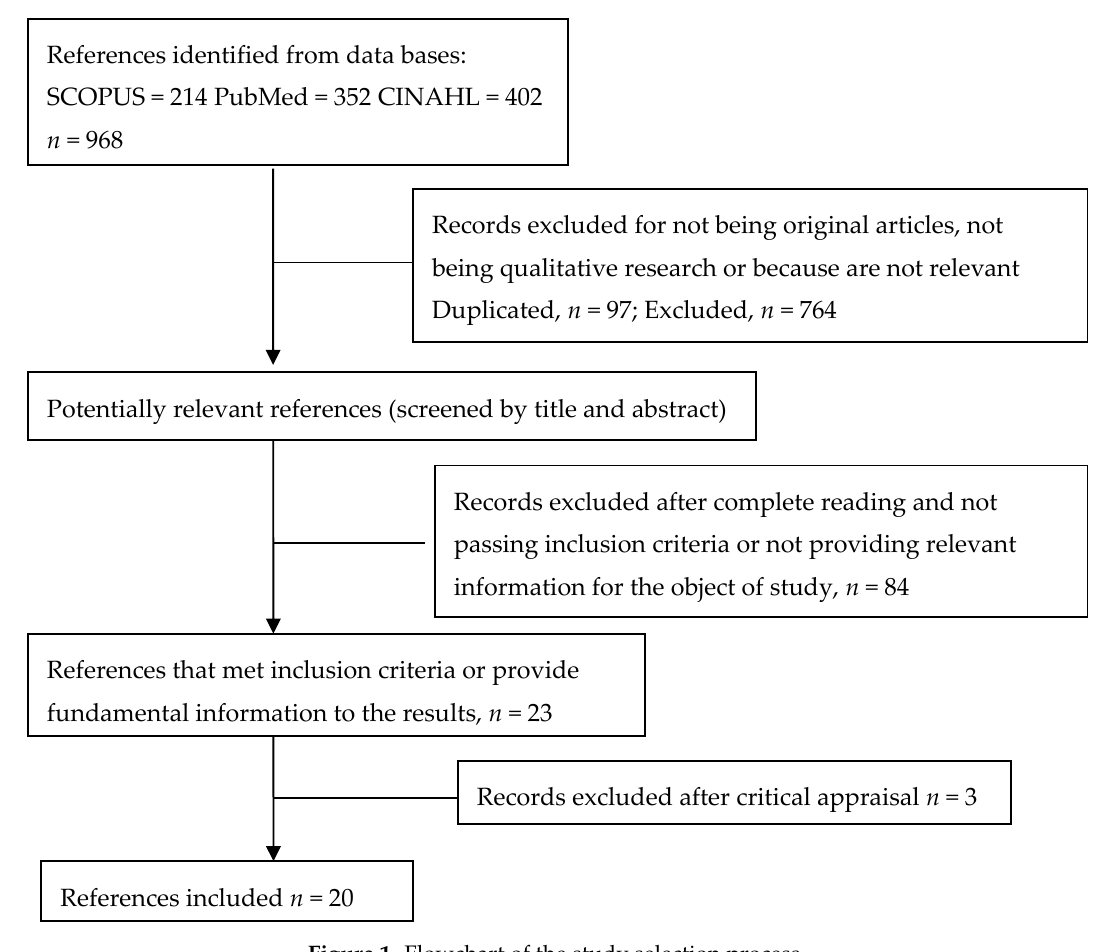
Figure 1. Flowchart of the study selection process.